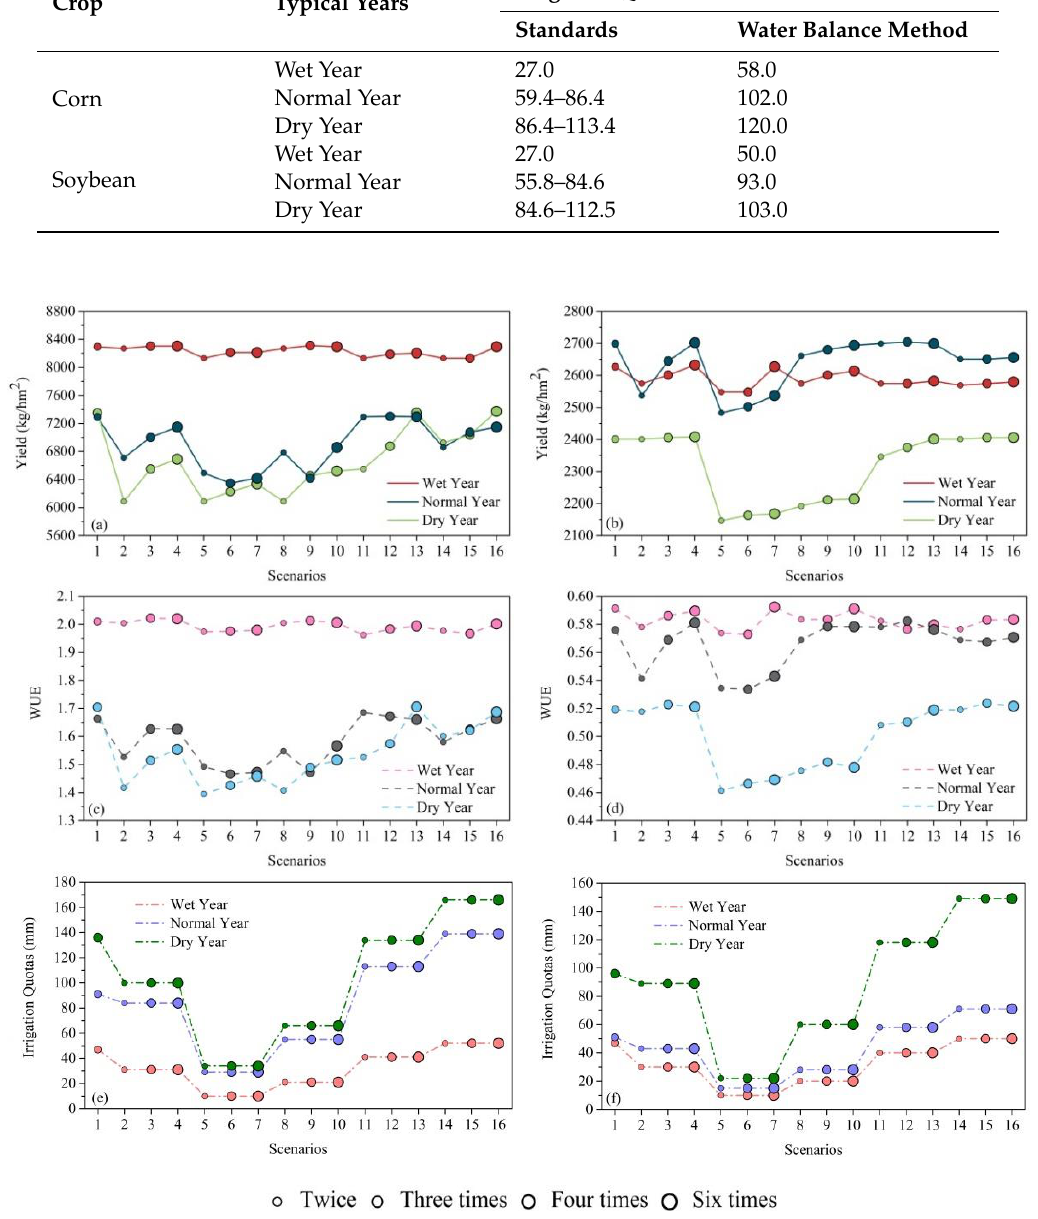
Figure 7. The results of irrigation scenarios. ( a ) corn yield, ( b ) soybean yield, ( c ) corn WUE, ( d ) soybean WUE, ( e ) corn irrigation quotas, ( f ) soybean irrigation